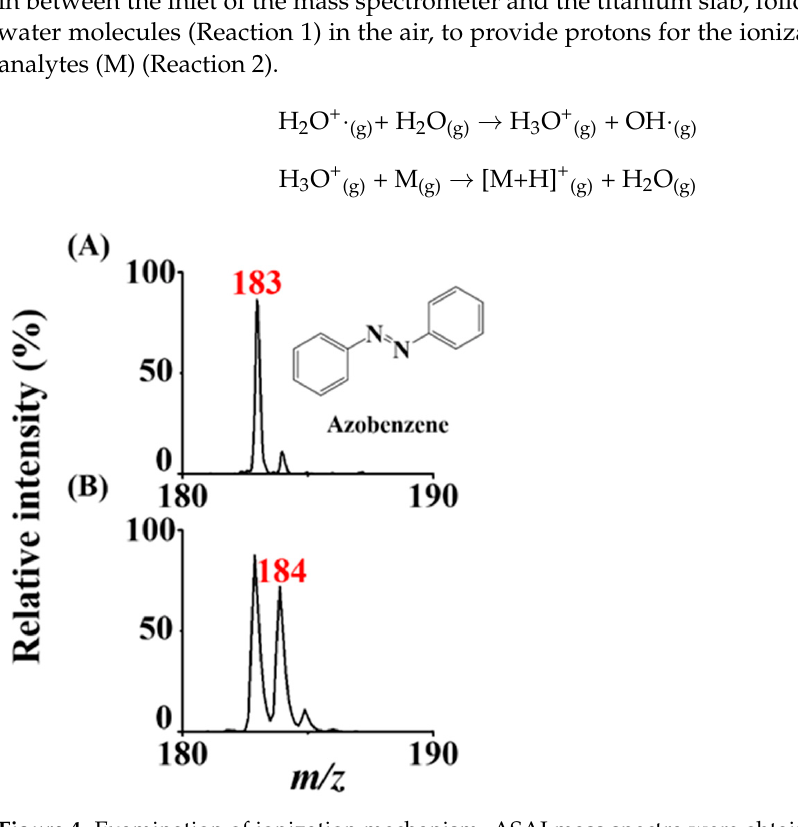
Figure 4. Examination of ionization mechanism. ASAI mass spectra were obtained by depositing azobenzene (0.2 nmole) on the titanium slab (0.3 cm × 0.3 cm) ( A ) without and ( B ) with boiling D 2 O underneath the titanium slab. The distance between the titanium slab and the inlet of the mass spectrometer was ~0.1 mm. The voltage set on the inlet of the mass spectrometer was − 4500 V.